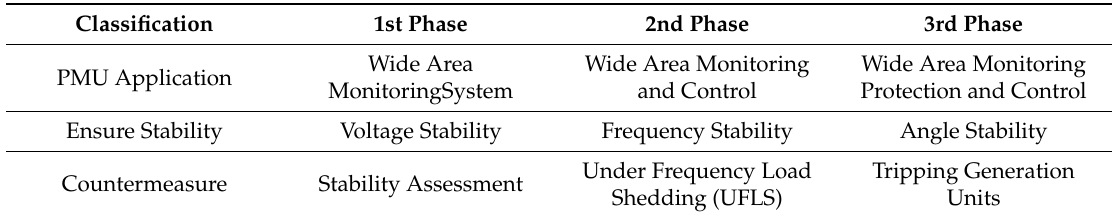
Table 5. Each technology phase target for phasor measurement unit (PMU) application.